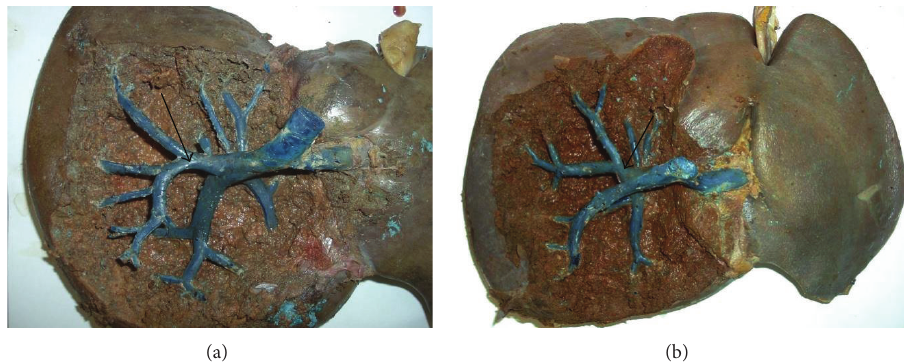
Figure 3: (a) Right posterior sectional pedicle in Rouviere’s sulcus. (b) Right anterior sectional pedicle in Rouviere’s sulcus.